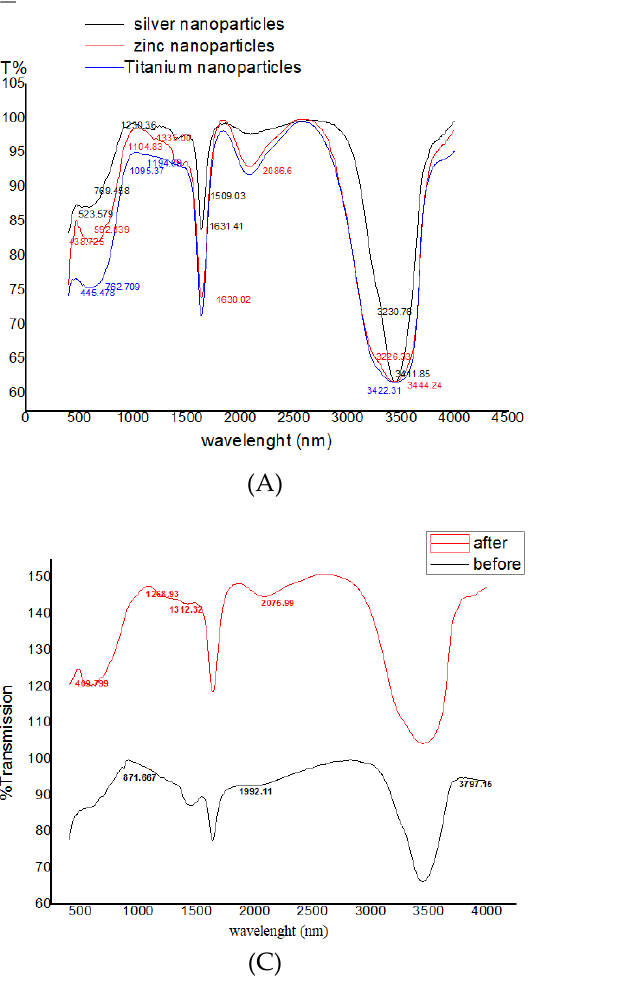
Figure 3. FTIR of ( A ) AgNPs, ZnONPs and TiO 2 NPs; ( B ) composite 500µL AgNPs–500µL ZnONPs; ( C ) composite 750µL AgNPs–250µL ZnONPs; ( D ) composite 750µL TiO 2 NPs–250µL ZnONPs before and after. AgNPs–250 µ L ZnONPs; ( D ) composite 750 µ L TiO 2 NPs–250 µ L ZnONPs before and